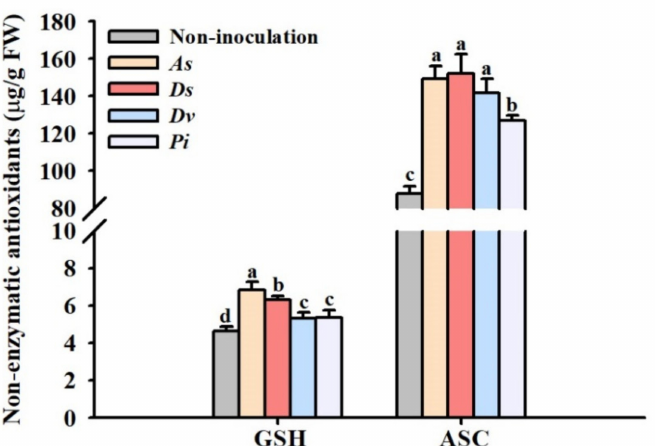
Figure 3. The effect of inoculation with Acaulospora scrobiculata ( As ), Diversispora spurca ( Ds ), D . ver- siformis ( Dv ), and Piriformospora indica ( Pi ) on leaf glutathione (GSH) and ascorbic acid (ASC) con- centration of the lane late navel orange trees. Data (means ± SD, n = 4) are significantly different ( p < 0.05) if followed by different letters above the